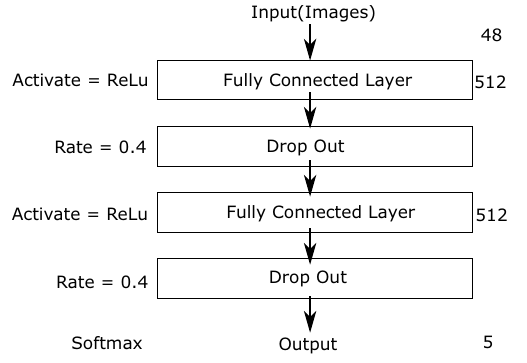
Figure 2. Discriminator architecture (ReLU, rectified linear